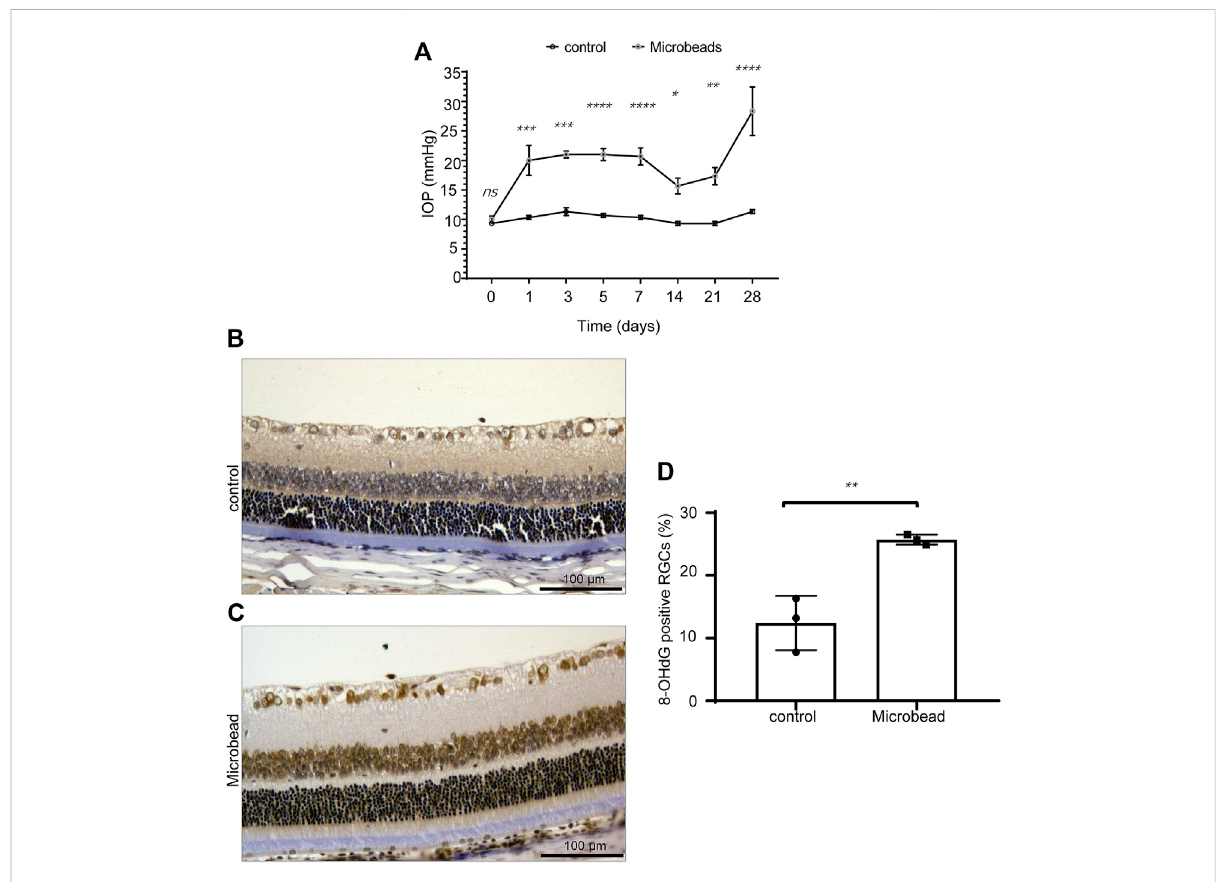
FIGURE 1 Chronic ocular hypertension-induced oxidative damage in RGCs. (A) Compared to the control group, the IOP of the microbead group was signi fi cantly increased. (B,C) the 8-OHdG + RGCs were signi fi cantly increased in the microbead group compared to the control group. Scale bar, 100 µm. (D) The p -values were determined using an unpaired Student ’ s t-test for two-group comparisons. p p < 0.05, pp p < 0.01, ppp p < 0.001, and pppp p <